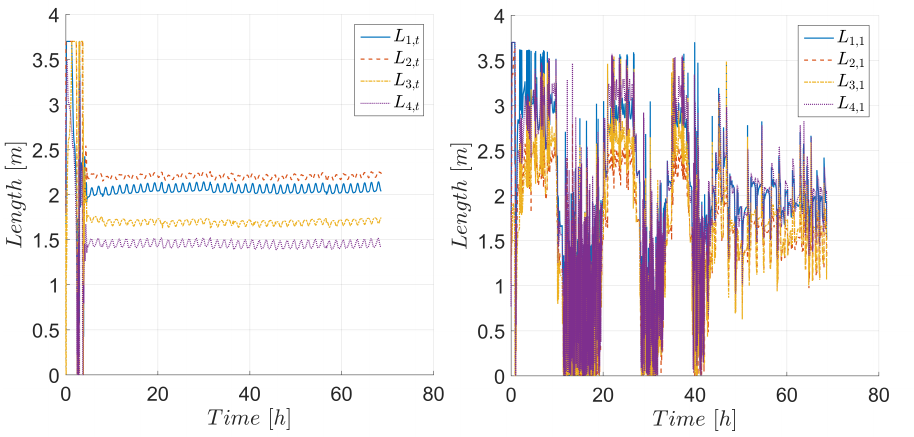
Figure 9. Required DMD surfaces lengths of the target ( left ) and chaser ( right ) for the roto- translational maneuver.